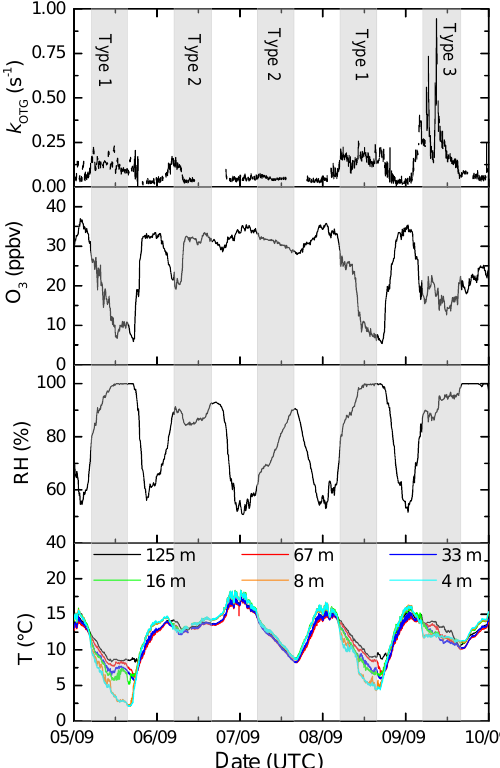
Figure 4. Expanded view of five campaign days illustrating the three types (1–3) of night encountered. Type 1 has a strong verti- cal gradient in temperature (T) and significant O 3 loss with relative humidity (RH) at 100%. Type 2 (no temperature inversion), has little or no O 3 loss. Type 3 is influenced by emissions from the Ko- rkeakoski